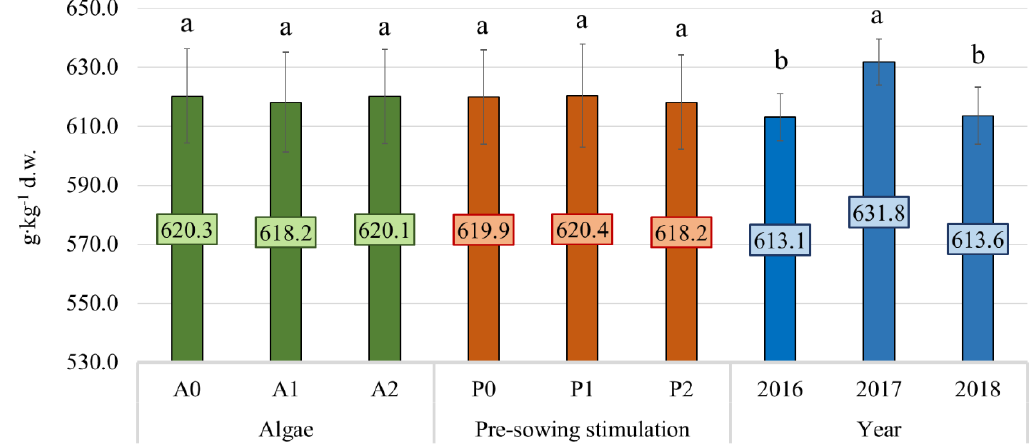
Figure 7. The mean raw fiber content of protein in oat grains in 2016–2018 depending on the experimental factors used. According to Tukey’s HSD test, the means marked with the same letter are not significantly different at α ≤ 0.05.